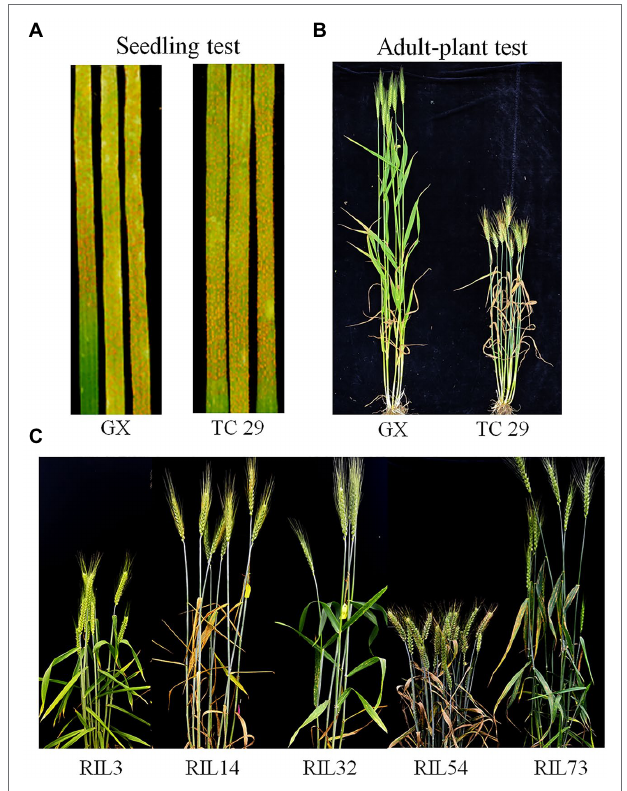
FIGURE 1 | Stripe rust response of the resistant parent Gaoxianguangtoumai (GX) and susceptible parent Taichung 29 (TC 29) with CYR34 at the seedling stage (A) and mixture Pst at the adult-plant stage (B) ; Stripe rust response of the randomly selected recombinant inbred lines (RILs) of lines in the field (C)